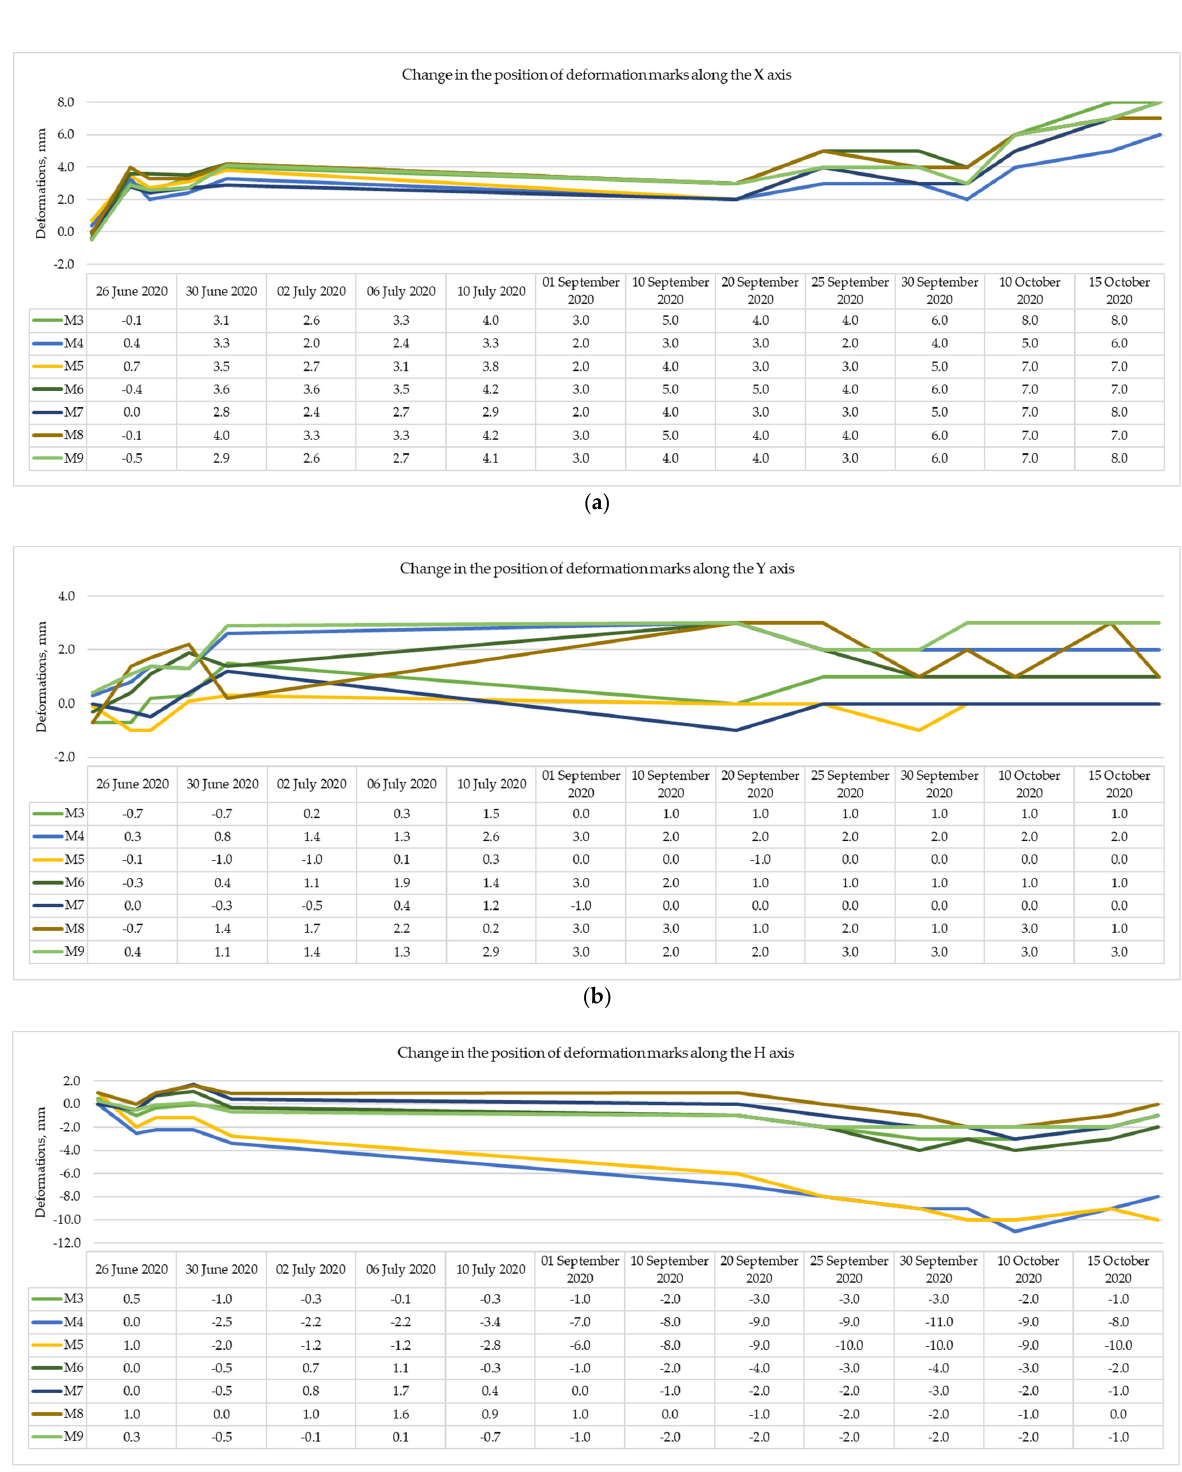
Figure 11. Graphs of subsidence of deformation marks fixed on the facade of a large-panel building damaged as a result of a gas explosion (Kyiv city, S. Krushelnytska Street). Two sets of observations: immediately after the explosion (June–July 2020) and after strengthening the structures (September– October 2020). Change in position of deformation marks along the X axis ( a ), Y axis ( b ), H axis ( c ).